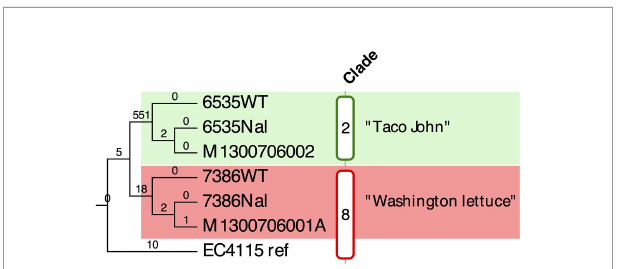
FIGURE 2 | Maximum parsimony (MP) SNP-based tree of analyzed laboratory and clinical EHEC O157:H7 strains Comparison of the six genomes yielded a total of 588 SNPs of which 572 were parsimony informative. The tree shown is a majority-consensus tree of 100 equally parsimonious trees with a consistency index of 0.998 and was recovered using a heuristic search in Paup 4.0a163 (Wilgenbusch and Swofford, 2003). The phylogeny revealed two distinct clusters comprised of laboratory strains 7386 and 6535 and respective derived NalR mutants and clinical isolates recovered from the patient. The SNP tree unambiguously identi fi ed the two laboratory strains as source of this life threatening O157:H7 co-infection. As evidenced both patient recovered strains form tight clonal clusters with their respective laboratory progenitor strains and the tree topology unambiguously identi fi ed the laboratory strains as progenitor and thus source of the researchers ’ infection. Only nodes with bootstrap values below 100 are